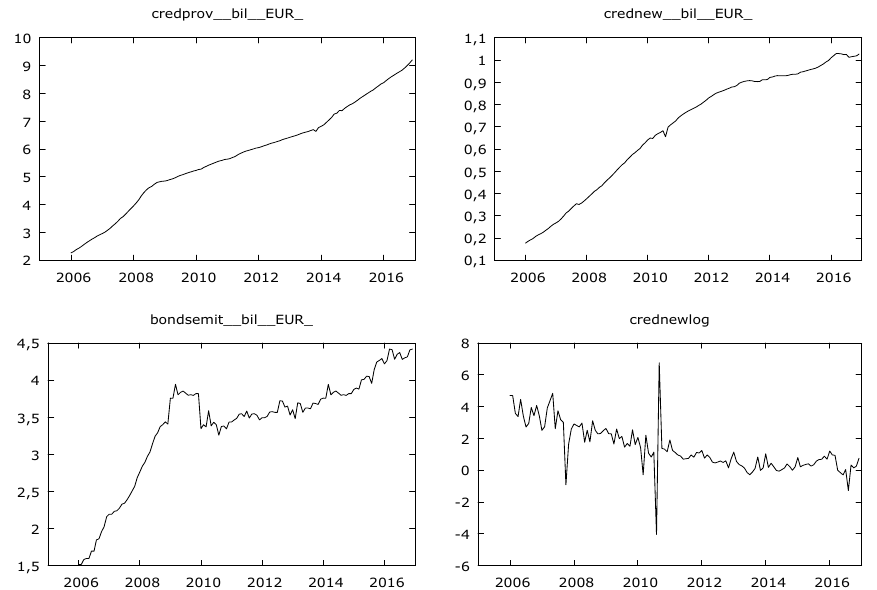
Figure 1. The the volume of “credprov” = provided credits, “crednew” = new credits, “bondsemit” = amount of issued bonds, “crednewlog” = logarithm of provided loans. Source: National Bank of Slovakia 2018.